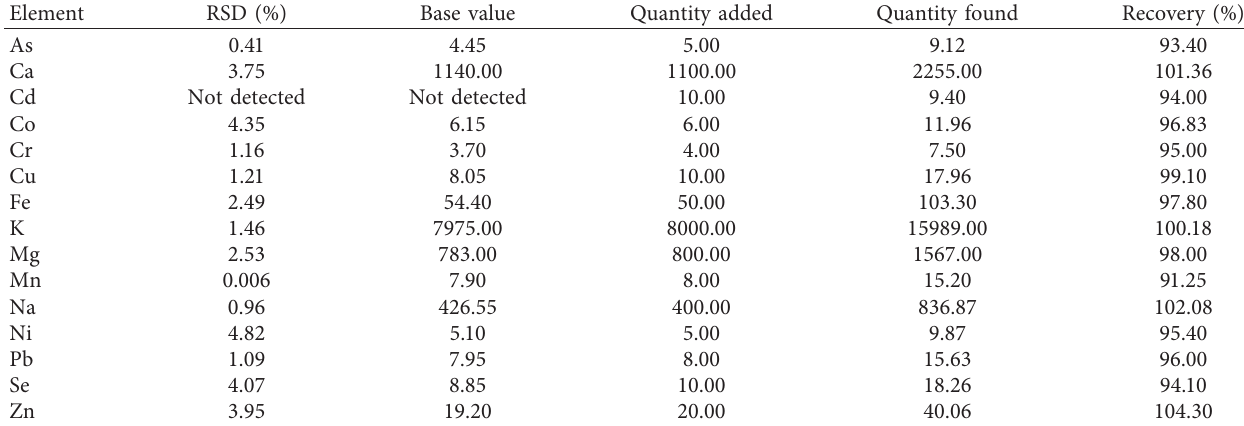
Table 6: Accuracy and recovery of determination